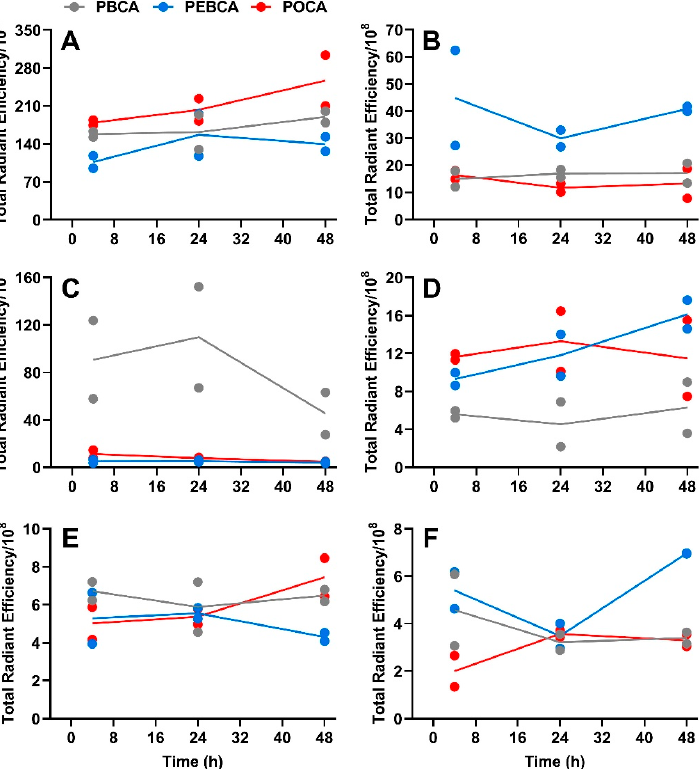
Figure 3. Quantification of fluorescence intensity as relative radiant efficiency/10 8 pixel data of organs in MAS98.12 tumor-bearing mice collected at different time points after the injection of NR668-loaded PACAs. The fluorescence intensity data for the three PACAs are compared for the various tissues, i.e., in liver ( A ), spleen ( B ), lungs ( C ), lymph nodes ( D ), kidneys ( E ), and tumors ( F ); PBCA (gray), PEBCA (blue), and POCA (red). Since the fluorescence intensity was somewhat different for the three preparations, this is corrected for by multiplying the PBCA values with 0.91 and the POCA values with 0.79. Lines connect the mean of the two individual data points.